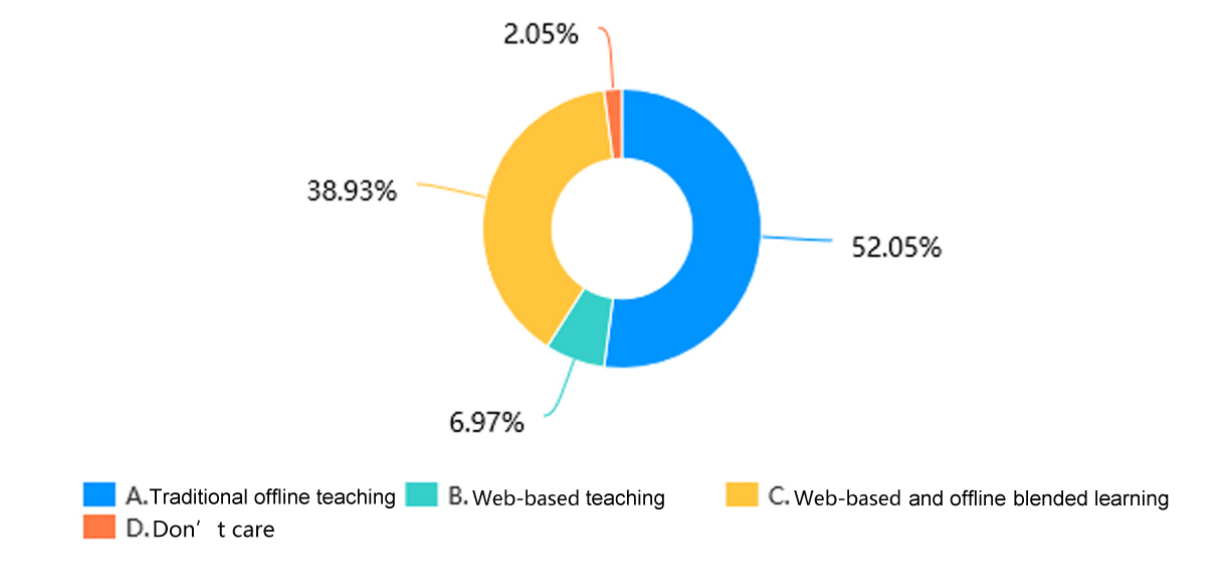
Figure 7. The proportions of students who chose different teaching methods of histology and embryology after the COVID-19 epidemic.